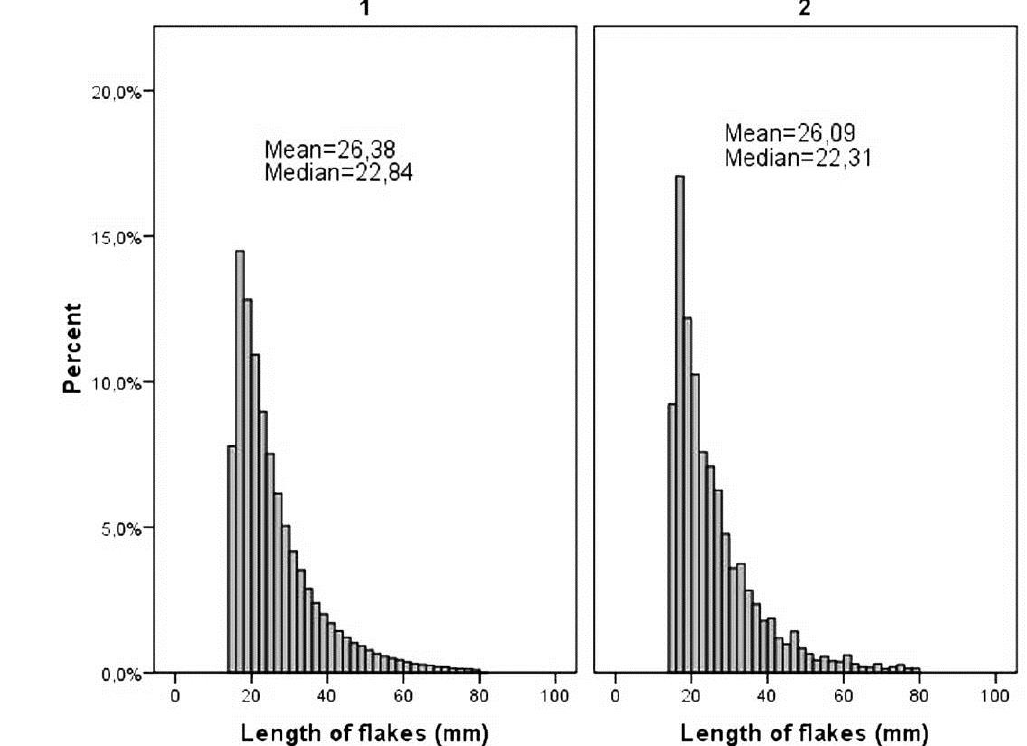
Figure 13. Comparison of flake length distributions (only flakes >15 mm) in the Fofanovo 13 assemblage and the experimental assemblage. P-value of two-sample K-S test is